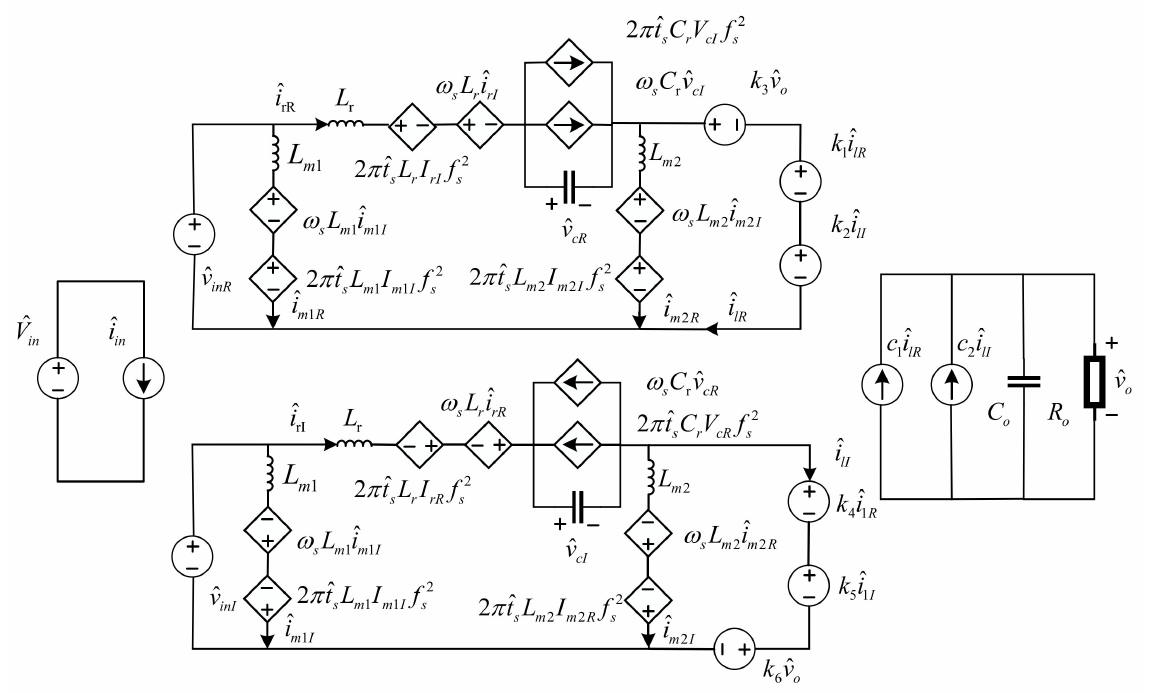
Figure 7. Small signal model of bidirectional LLC resonant